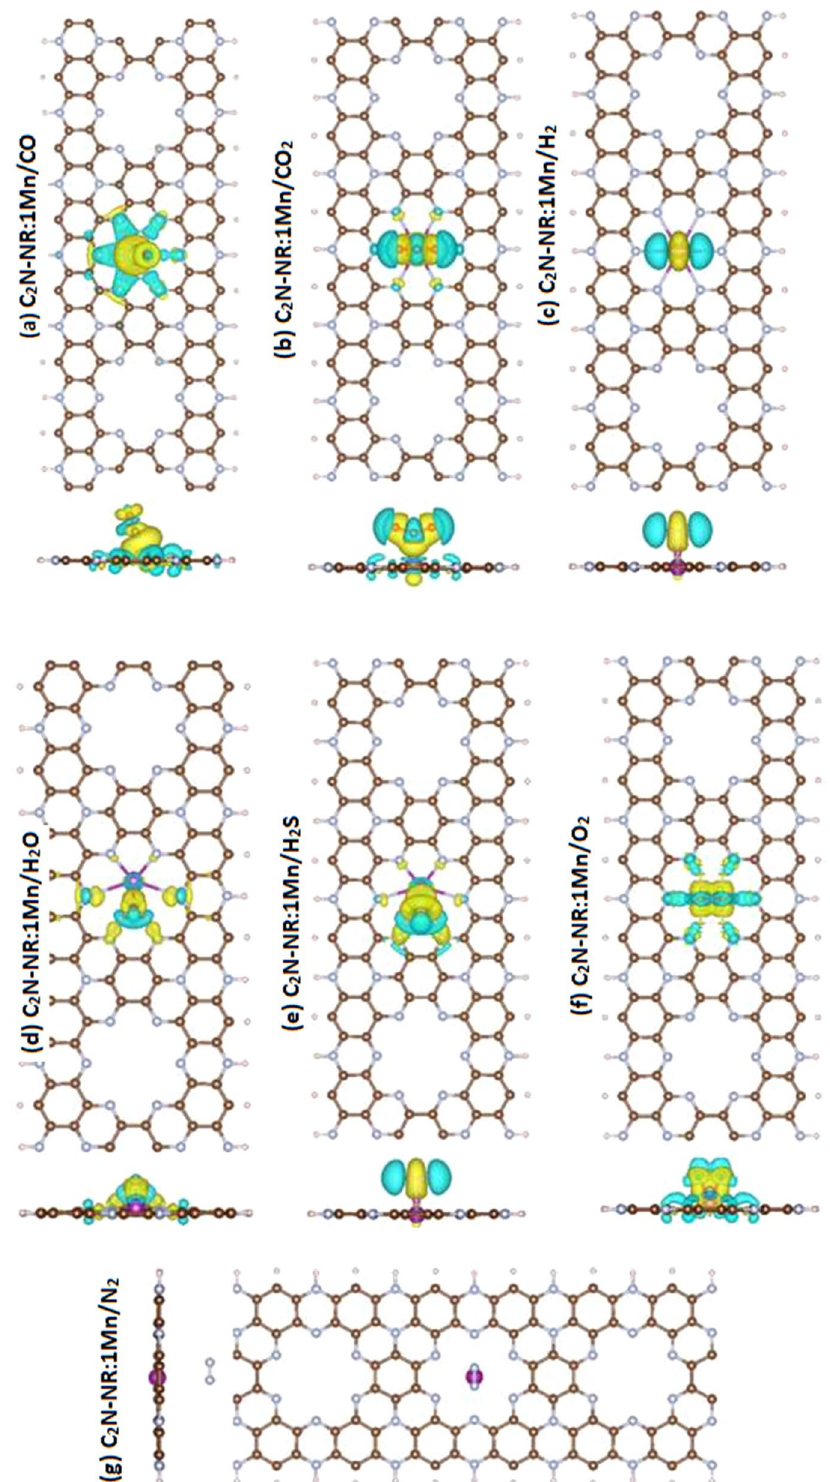
Figure. 6. Charge-difference density plots for C 2 N-NR:1Mn with various gas molecules. Yellow (cyan) color indicates charge depletion